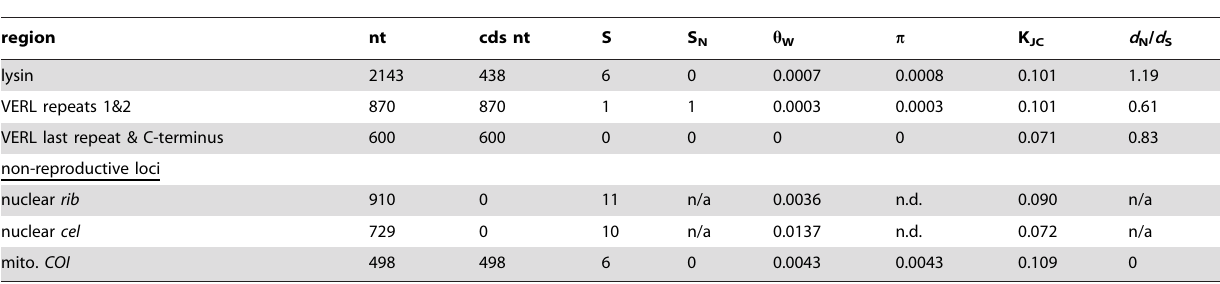
Table 1. Green abalone polymorphism and divergence.